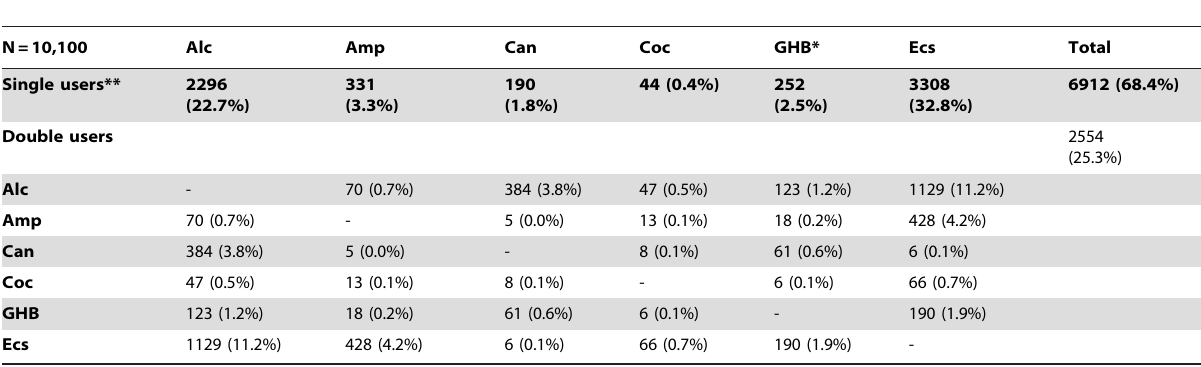
Table 2. Number of individual and multiple substance-using first aid visitors.